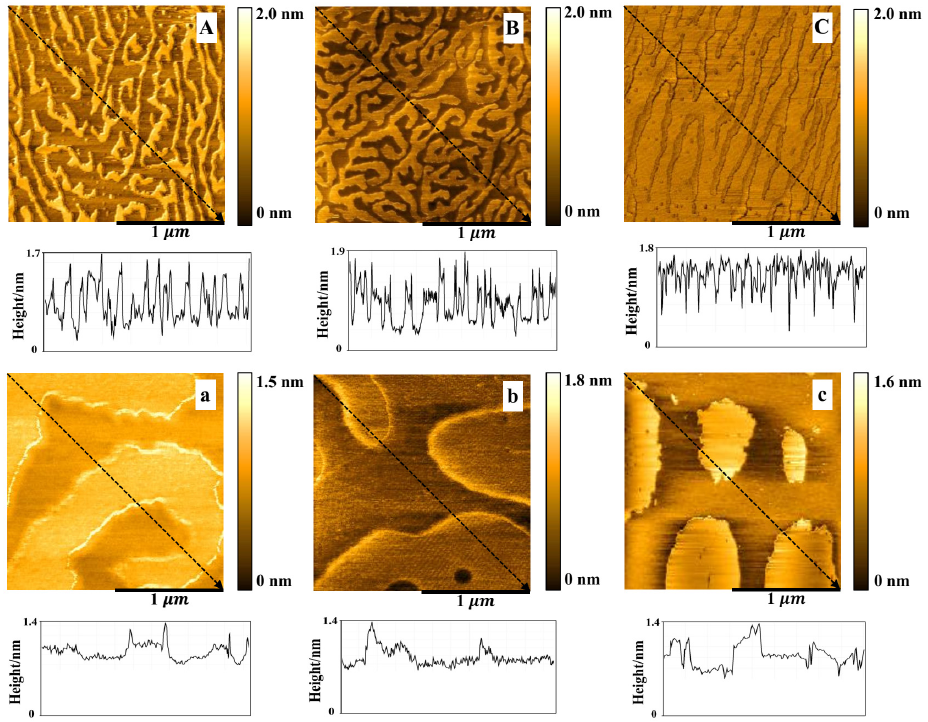
Figure 5. The AFM images (2 µ m × 2 µ m) of the DPPC/Chol mixed Langmuir–Blodgett film without ( A , B , C ) and with AmB ( a , b , c ) in the absence ( A , a ) and presence of 5 mmol/L ( B , b ) and 10 mmol/L ( C , c ) K + ions at 15 mN/m.